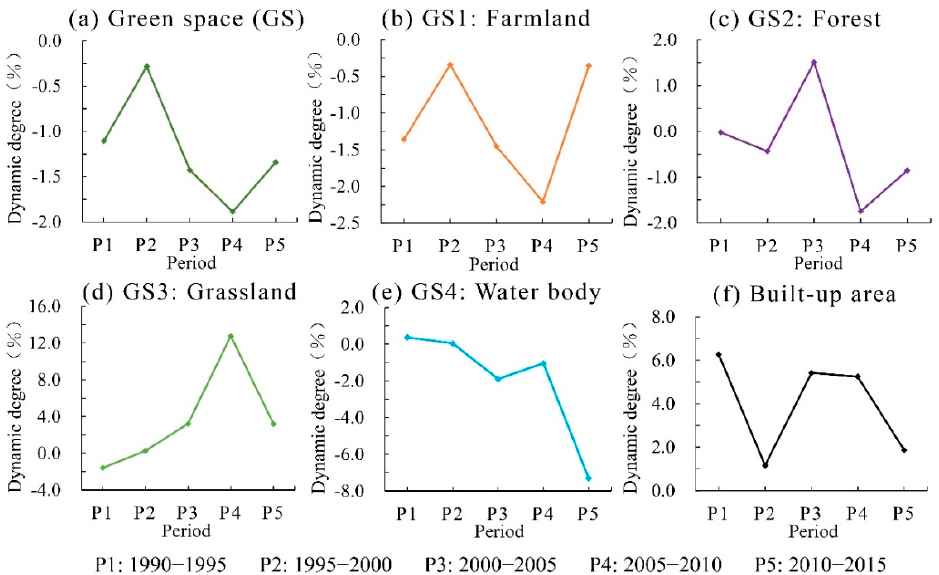
Figure 8. The dynamic change degree (DCD) of the green space. ( a ) The DCD of overall green space; ( b ) The DCD of farmland; ( c )The DCD of forest; ( d ) The DCD of grassland; ( e ) The DCD of water body; ( f ) The DCD of built-up area.